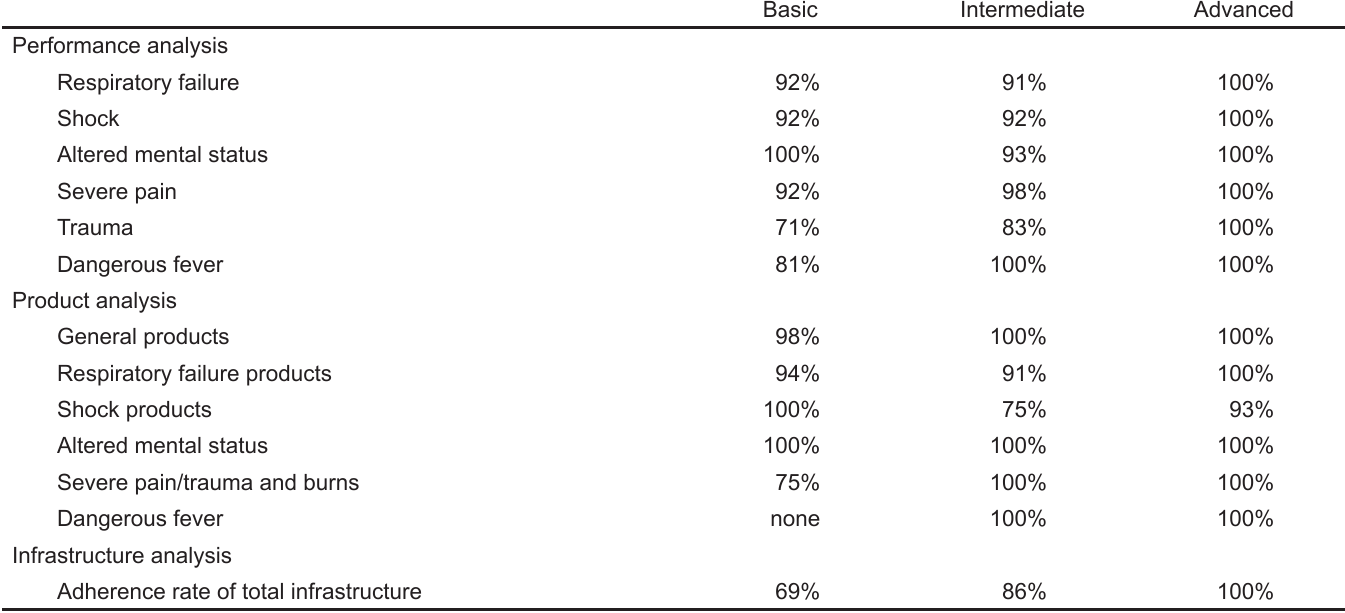
Table 6. Adherence rate to signal function for each sentinel condition in each category of